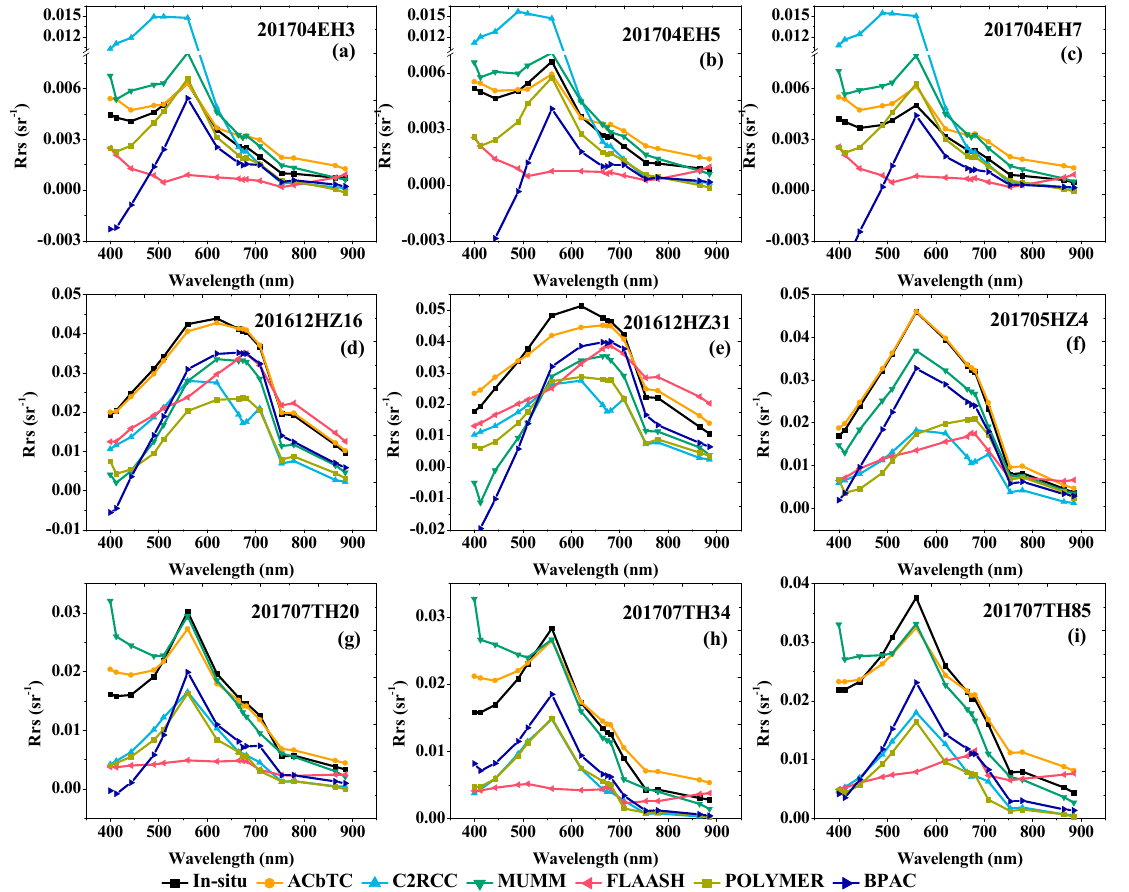
Figure 9. Comparison between in situ measurements and derived R rs values of six algorithms, including the ACbTC, C2RCC, MUMM, FLAASH, POLYMER, and BPAC denoted by the different colors and symbols. The X -axis represents the wavelength range and the Y -axis represents the R rs values.